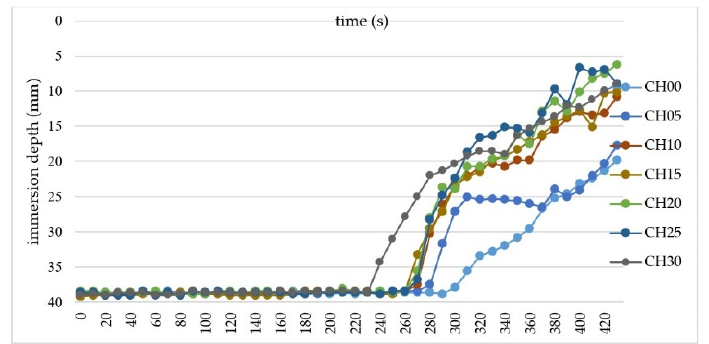
Figure 2. Cement-based mortar setting